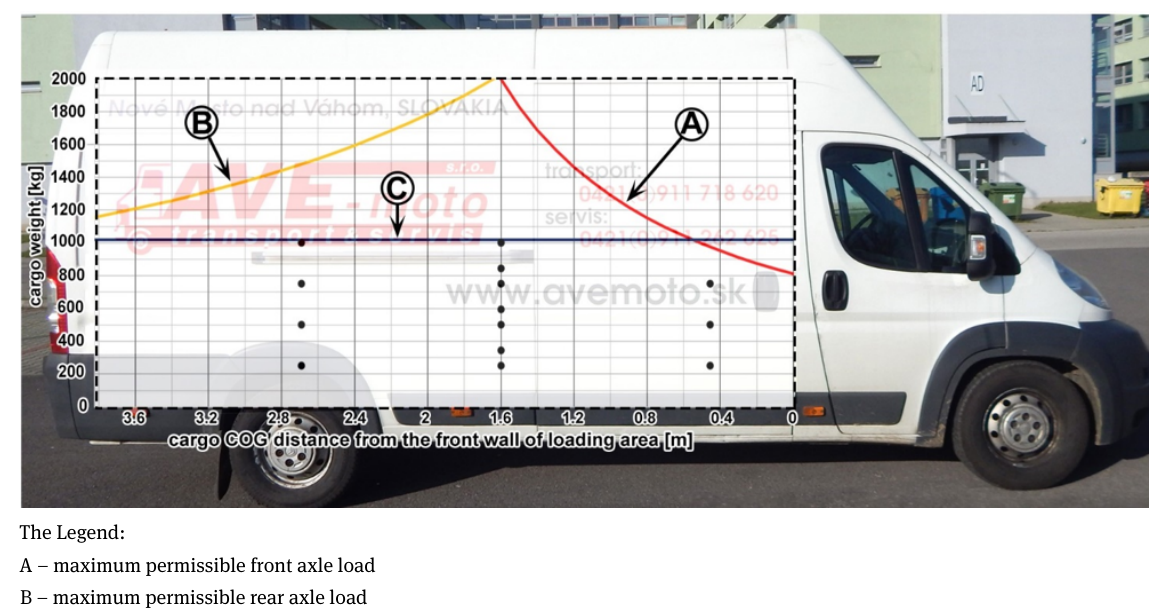
Figure 1: Load distribution diagram of Citroen Jumper L4H3. Source: Authors